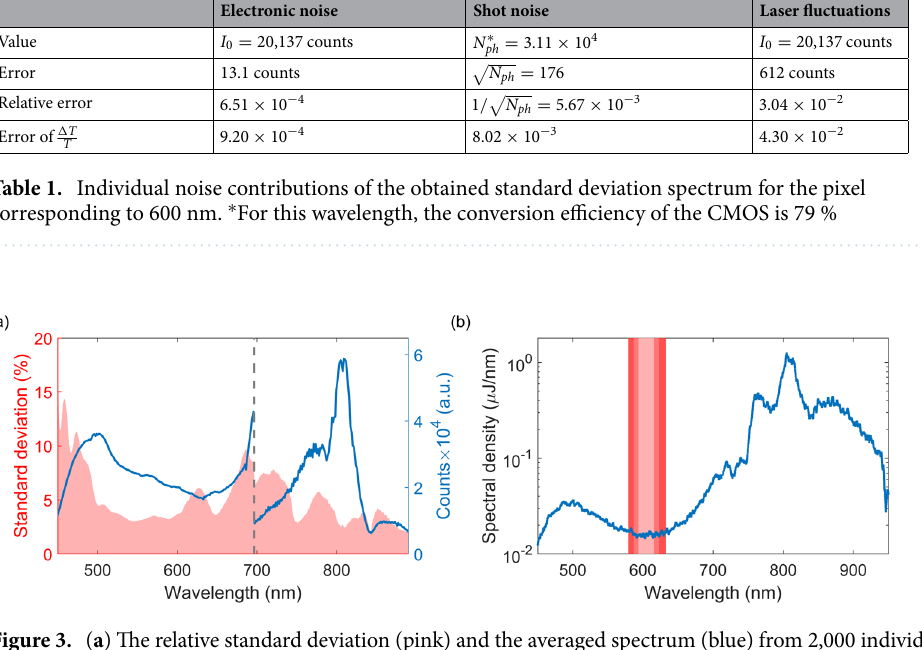
Figure 3. ( a ) The relative standard deviation (pink) and the averaged spectrum (blue) from 2,000 individually measured pulses generated by the MPC. The spectrum is the result of 2 separate measurements merged at 696 nm, indicated by the grey dashed line. The saturation level is at about 65,536 counts (16-bit). ( b ) The available spectral density of the pulse after the compression stage. The pink lines indicate the spectral width required for a 20 fs (dark), 30 fs (middle) and 50 fs (light) pulse duration centered at 605